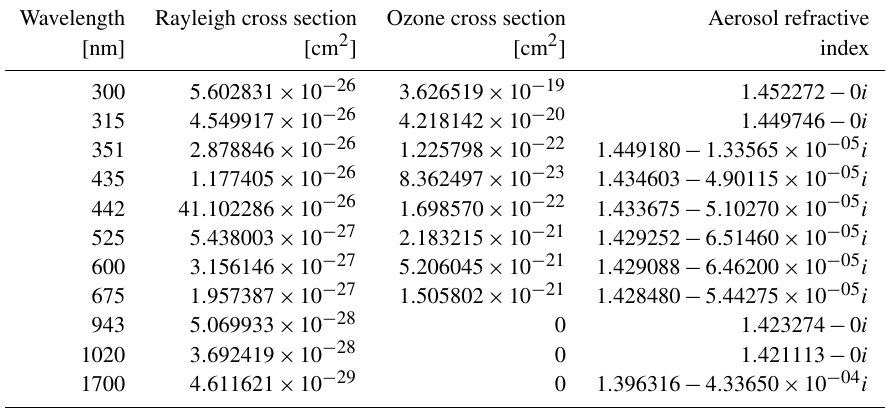
Table 2. The Rayleigh scattering cross section, ozone absorption cross section, and stratospheric aerosol refractive index used for the test cases.